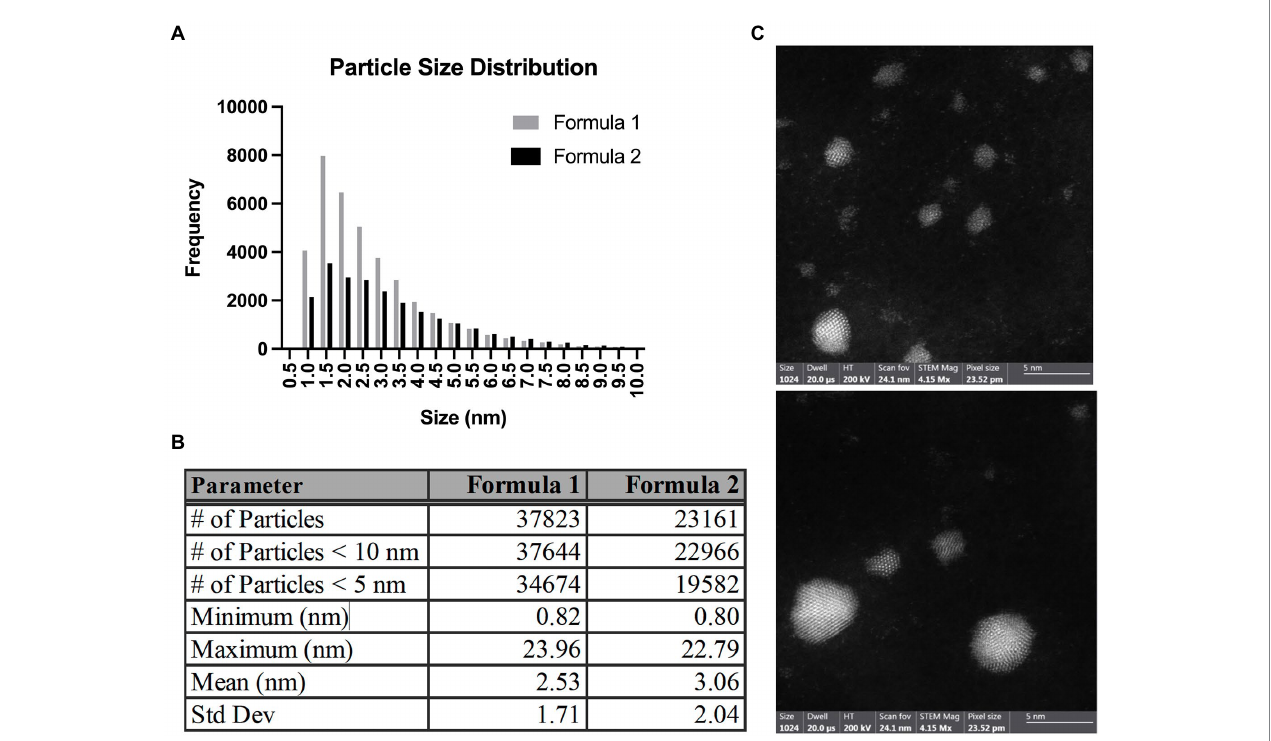
FIGURE 1 Size distribution of AgNPs. (A) A graph showing particle size distribution for Formula 1 and 2 AgNPs. (B) Measurement parameters were obtained for Formula 1 and 2 AgNP samples. (C) Select electron micrographs of silver nanoparticles under high-angle annular dark-field STEM mode. Scale bar = 5 nm.